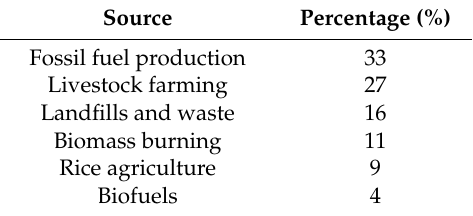
Table 2. Anthropogenic sources of methane (Data source: Bousquet et al.